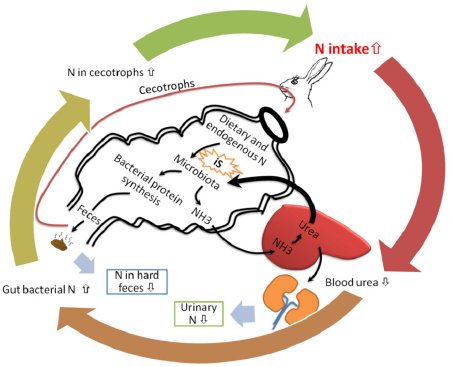
Figure 4. Effect of dietary indigestible sugars (iS) on nitrogen (N) metabolism and utilization in rabbits and guinea pigs.